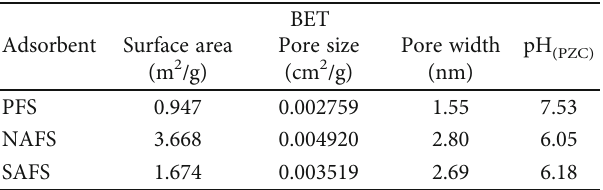
Table 2: Physicochemical characterization of pure (PFS) and treated (NAFS and SAFS) fennel seed adsorbents.